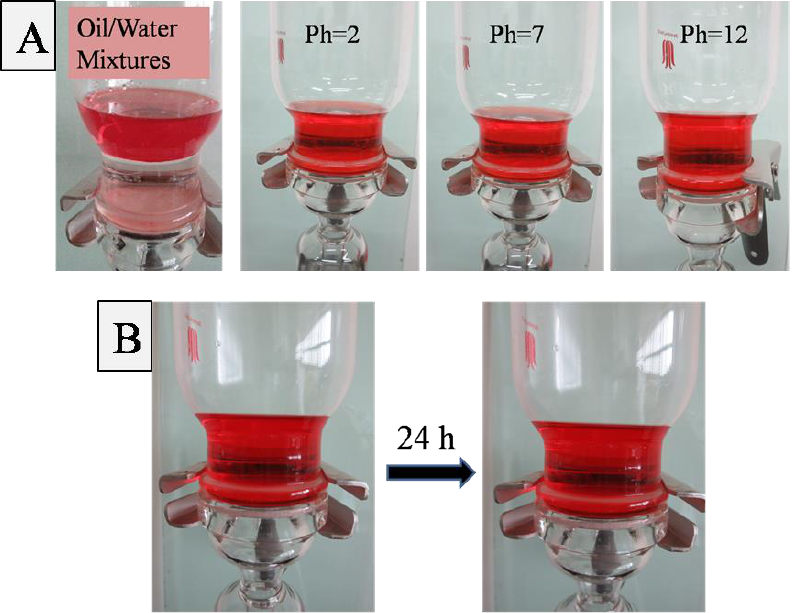
Figure 9. Oil/water separation experiment for PVDF-F127-P (MMA-AA) membrane: ( A ) the water including acidic and basic water permeating through the membrane; ( B ) hexadecane permeating through membrane after 24 h.